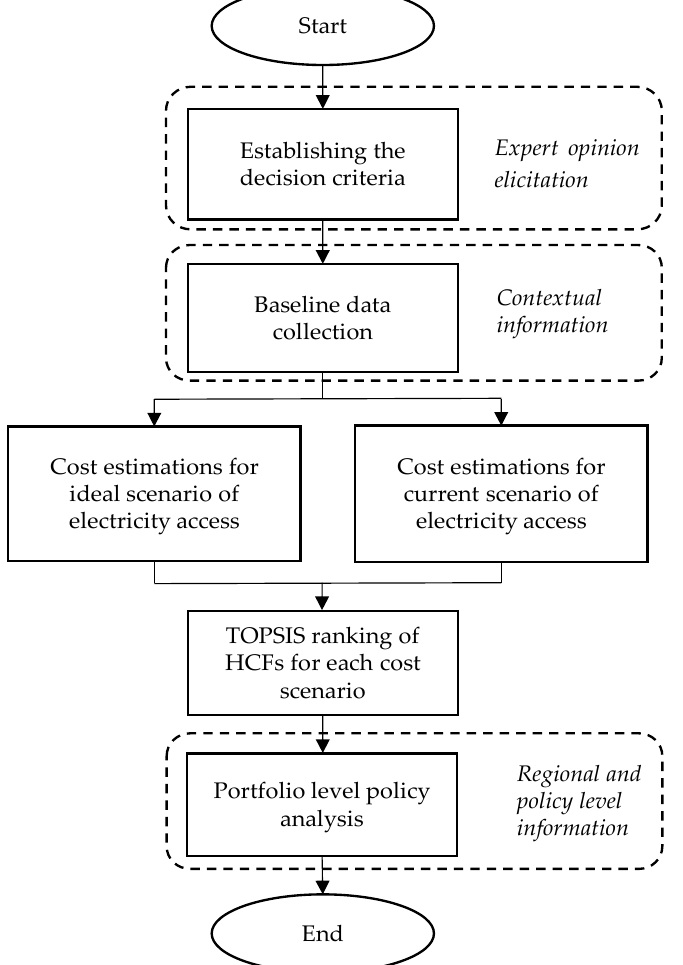
Figure 1. The flowchart of the DREAM method used for systematic energy access planning for HCFs.